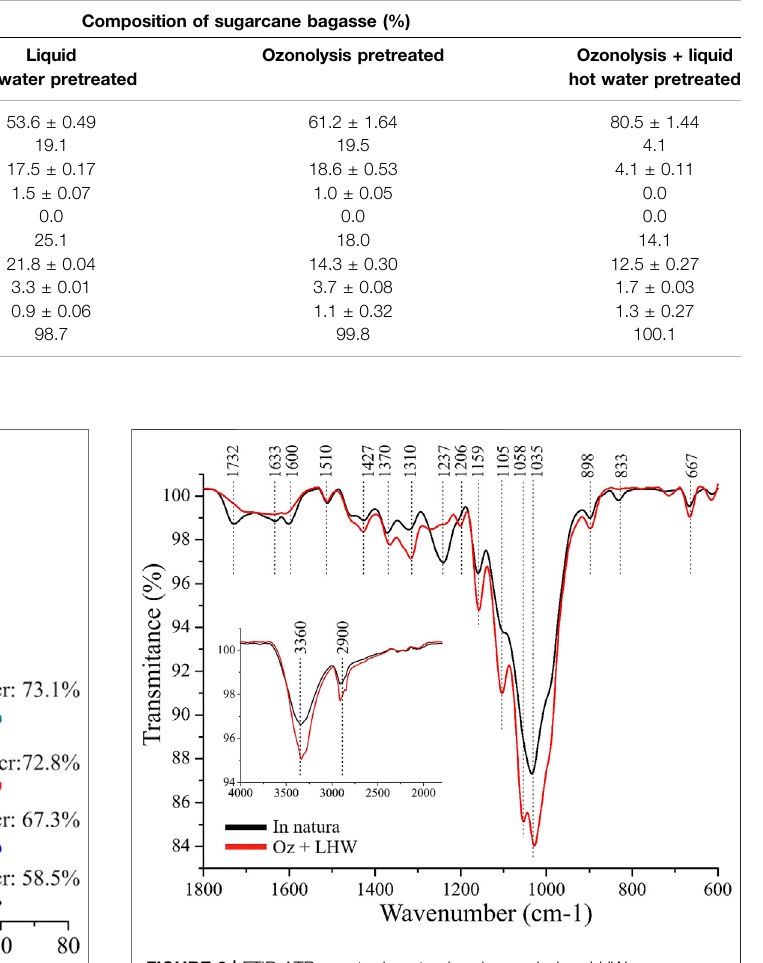
FIGURE 2 | FTIR-ATR spectra in natural and ozonolysis + LHW sugarcane bagasse